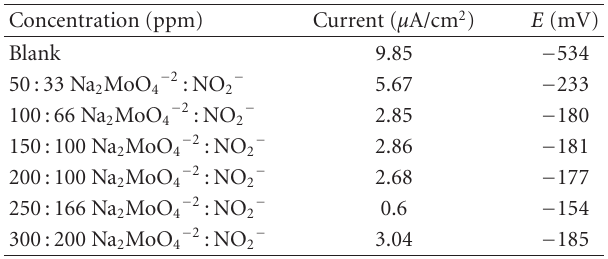
Table 2: Current potential data as a function of Na 2 MoO 4 :NaNO 2 concentration in a 1.5 :1 ratio.